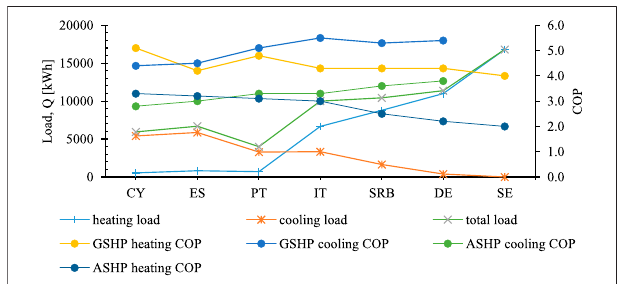
FIGURE 1 | Yearly heating and cooling loads per country for the same dwelling under